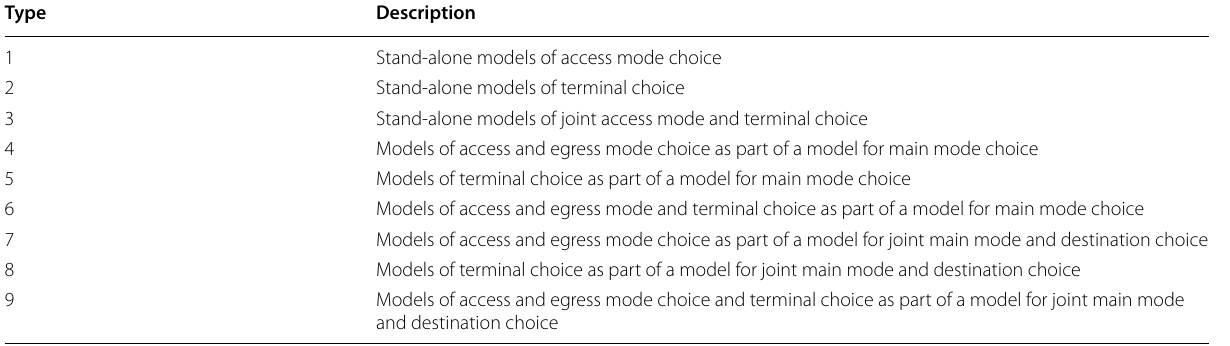
Table 1 Description of the model types in the developed typology for connection trip modelling Type